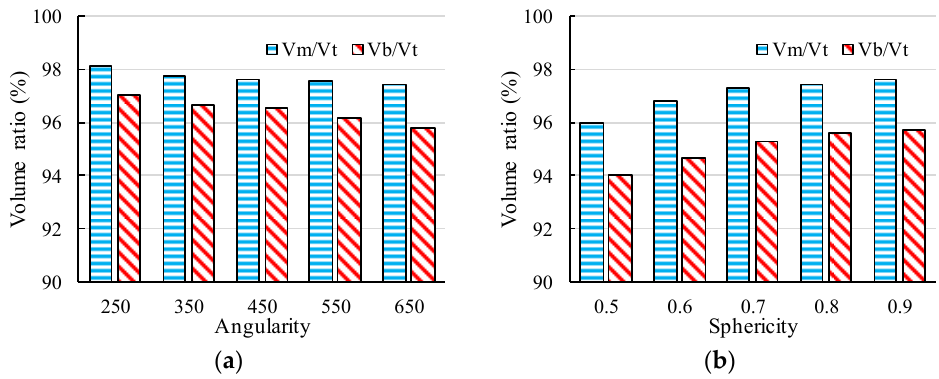
Figure 16. The volume ratio of aggregates at different parts affected by: ( a ) angularity; ( b ) sphericity.